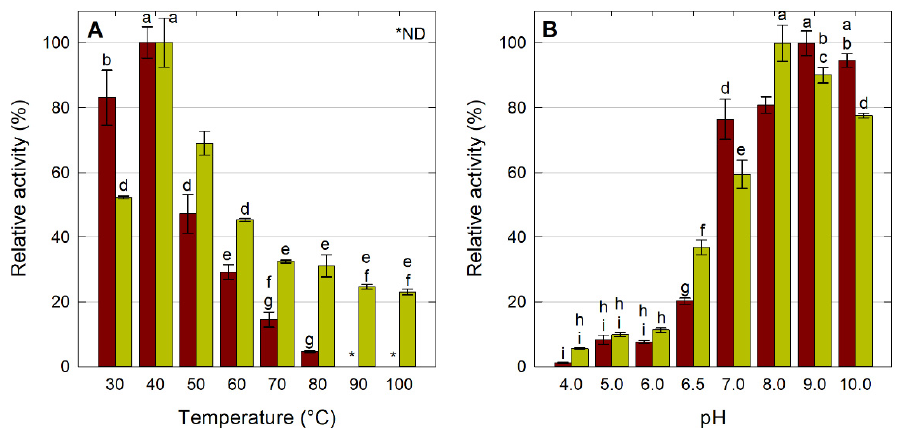
Figure 3. Characterization of LipMatCCR11-CLEAs. Effect of temperature ( A ) and pH ( B ) on lipolytic activity. All values are the mean of three replicates. Red: LipMatCCR11, Green: LipMatCCR11-CLEAs Error bars represent the standard deviation within the data set. Different lowercase letters indicate significant differences according to Tukey’s multiple comparison tests ( p < 0.05). The 100% value corresponds to a CLEA activity of 7755 ± 144 U/g. *: Non-detectable.